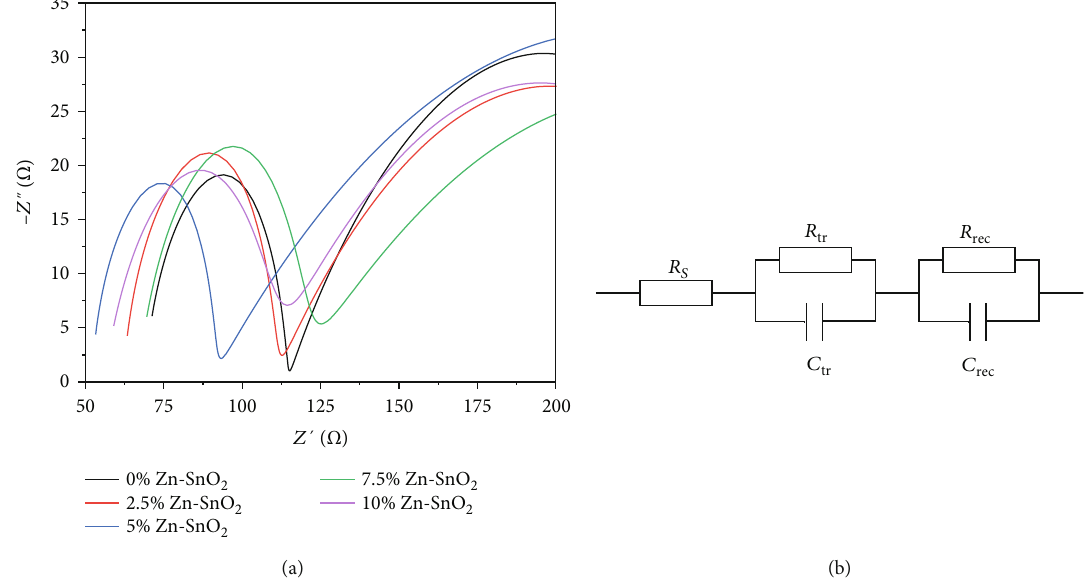
Figure 10: (a) Nyquist diagram of PSCs based on di ff erent doping concentrations of Zn-SnO Nyquist